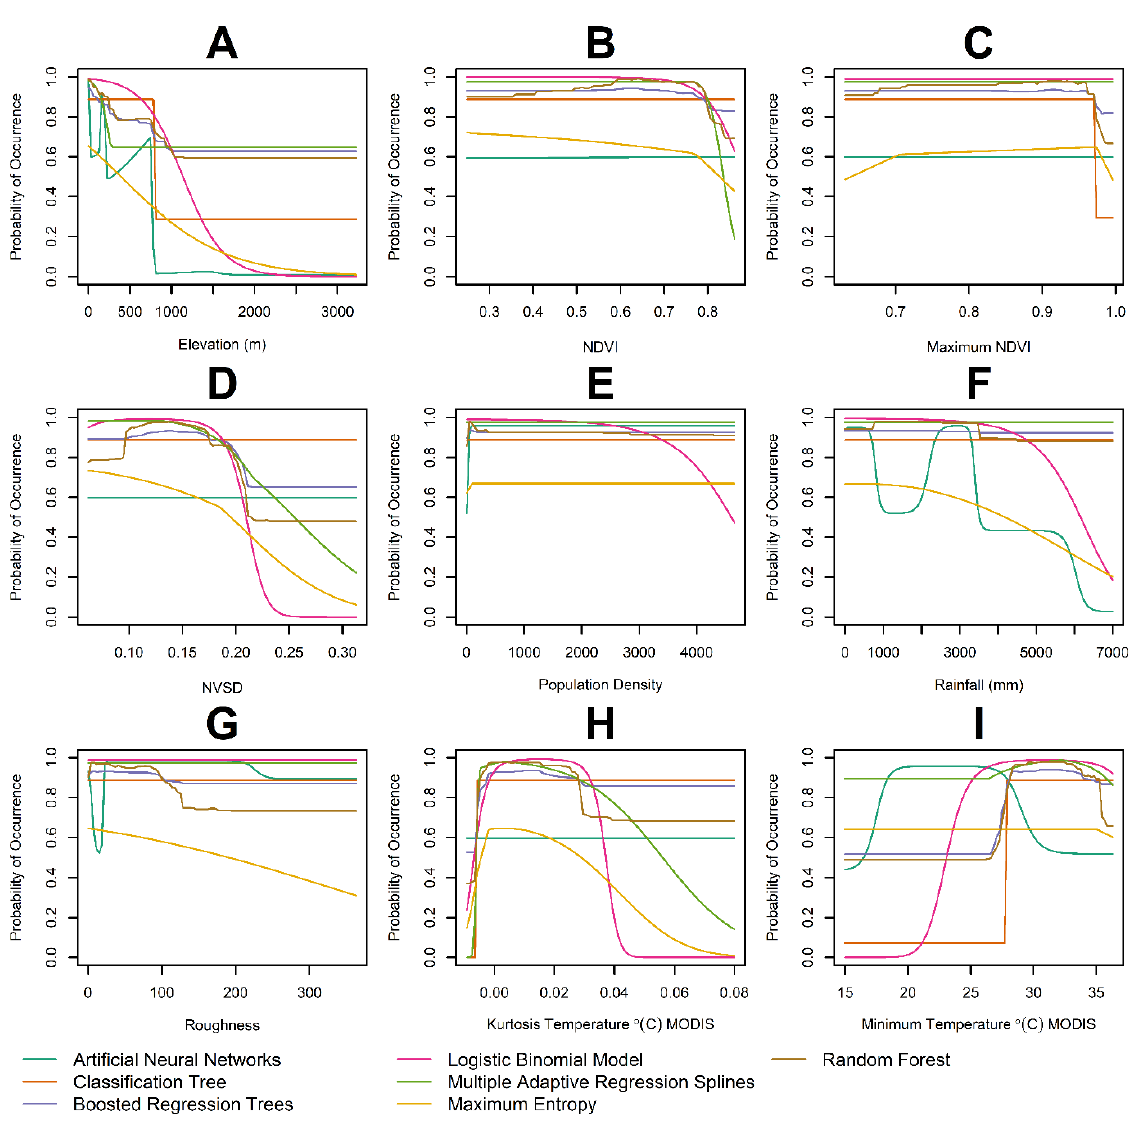
Figure 7. Strip plots of the predicted probability of Anopheles albimanus occurrence as function of the covariates considered in the ensemble of best models. In the plots, each line represents the mean for the replicated runs of each model. Model methodologies are color-coded (see bottom of the figure). Covariates included ( A ) elevation, ( B ) NDVI, ( C ) maximum NDVI, ( D ) SD of NDVI, ( E ) population density per km 2 , ( F ) rainfall measured in mm, ( G ) landscape roughness, ( H ) MODIS-based temperature kurtosis and ( I ) MODIS-based minimum temperature in °C.